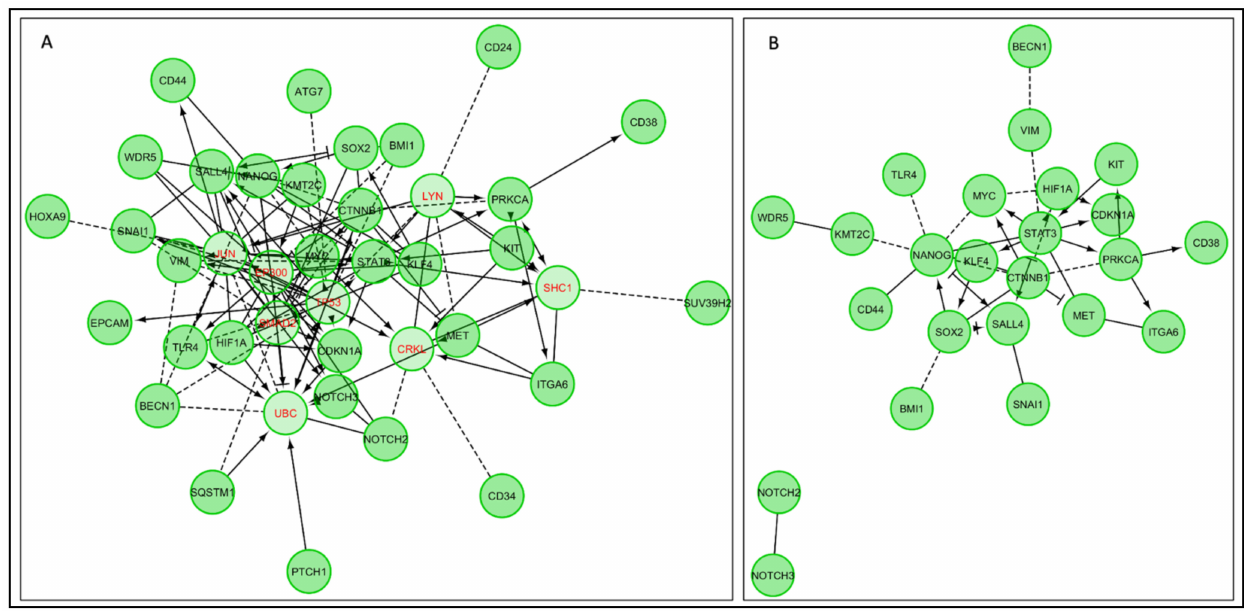
Figure 4. Reactome analysis of stemness proteins, CSC markers, autophagy genes, and lncRNAs discussed in this review ( A ) Reactome analyses of genes reviewed in this study and other genes that may provide a link between the genes discussed. ( B ) Reactome analyses performed using only genes reviewed in this study. Both analyses indicate functional interactions drawn from the Reactome database in Cytoscape. In this figure, edges indicate an interaction between two genes or their transcribed products. Dashed edges depict computationally predicted interactions with a probability of 0.95; solid edges indicate a shared protein complex or binding event. Arrowed edges indicate activation or catalytic activity, while blunted arrows indicate inhibition. Gene names in black are genes that were discussed in this review, while genes in red were not discussed in this review but were included because they provide a link between the genes discussed. Genes with no functional interactions are not